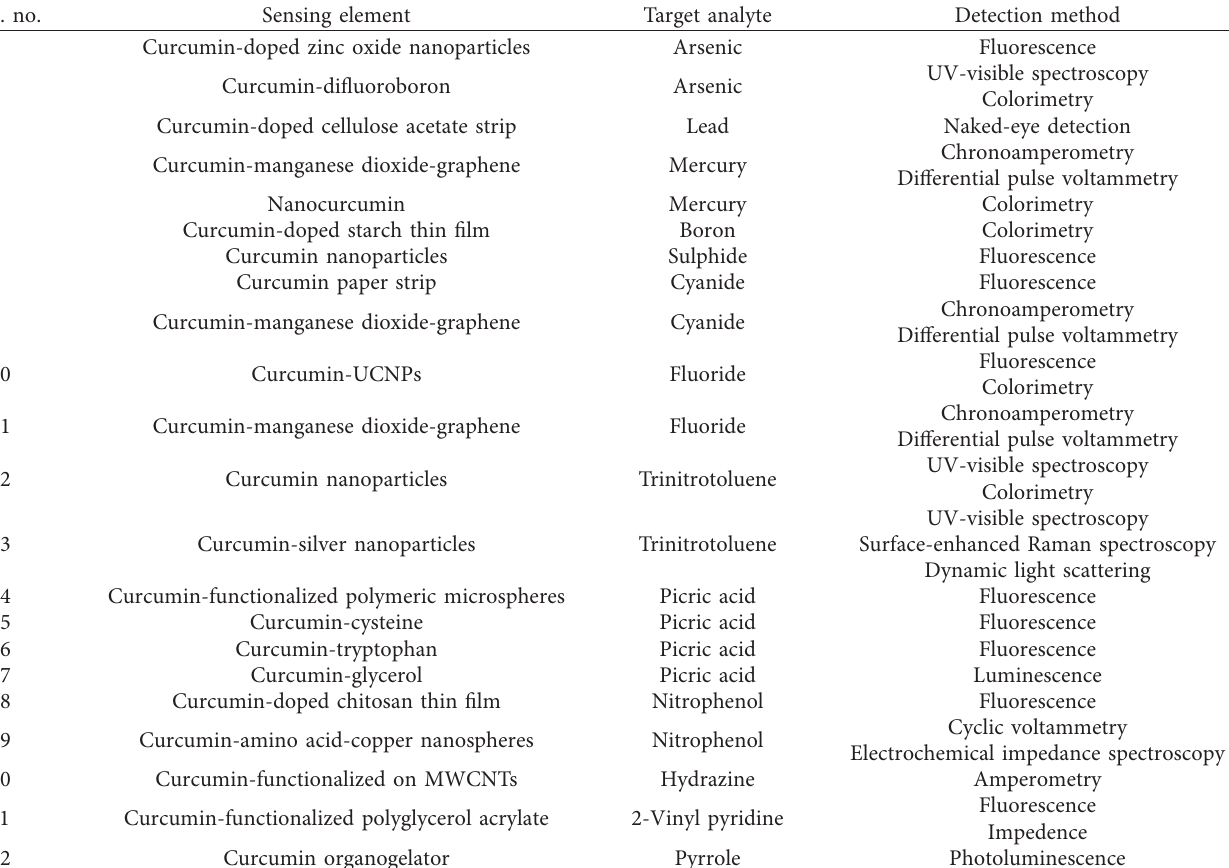
Table 1: Summary of curcumin-based electrochemical and optical sensing platform for detecting environmental pollutants. S.